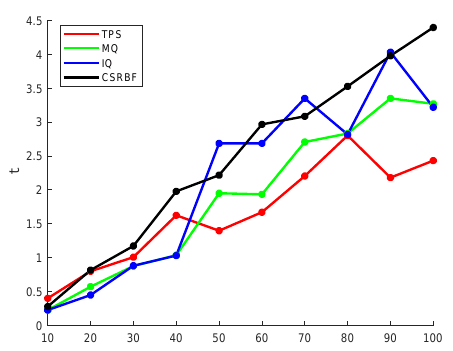
( b ) The computational time of the DFO method for the four kinds of basis functions to approximate g 2 ( x , y ) .